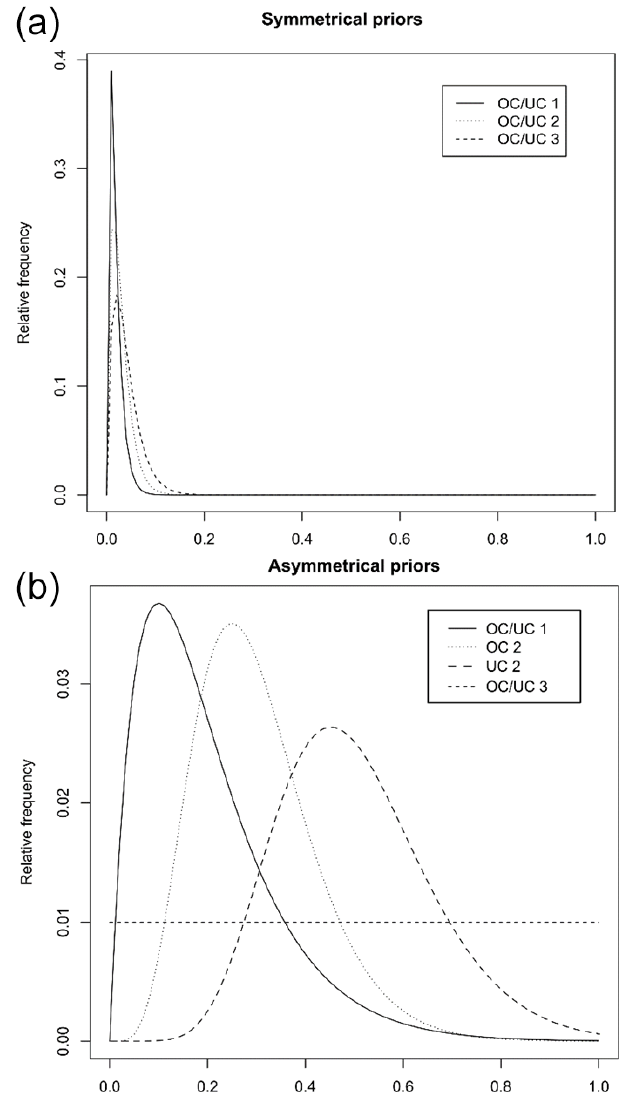
Figure 2. Lamination quality codes and their associated under- (UC) and over-counting (OC) gamma distribution priors for (a) symmetrical and (b) asymmetrical